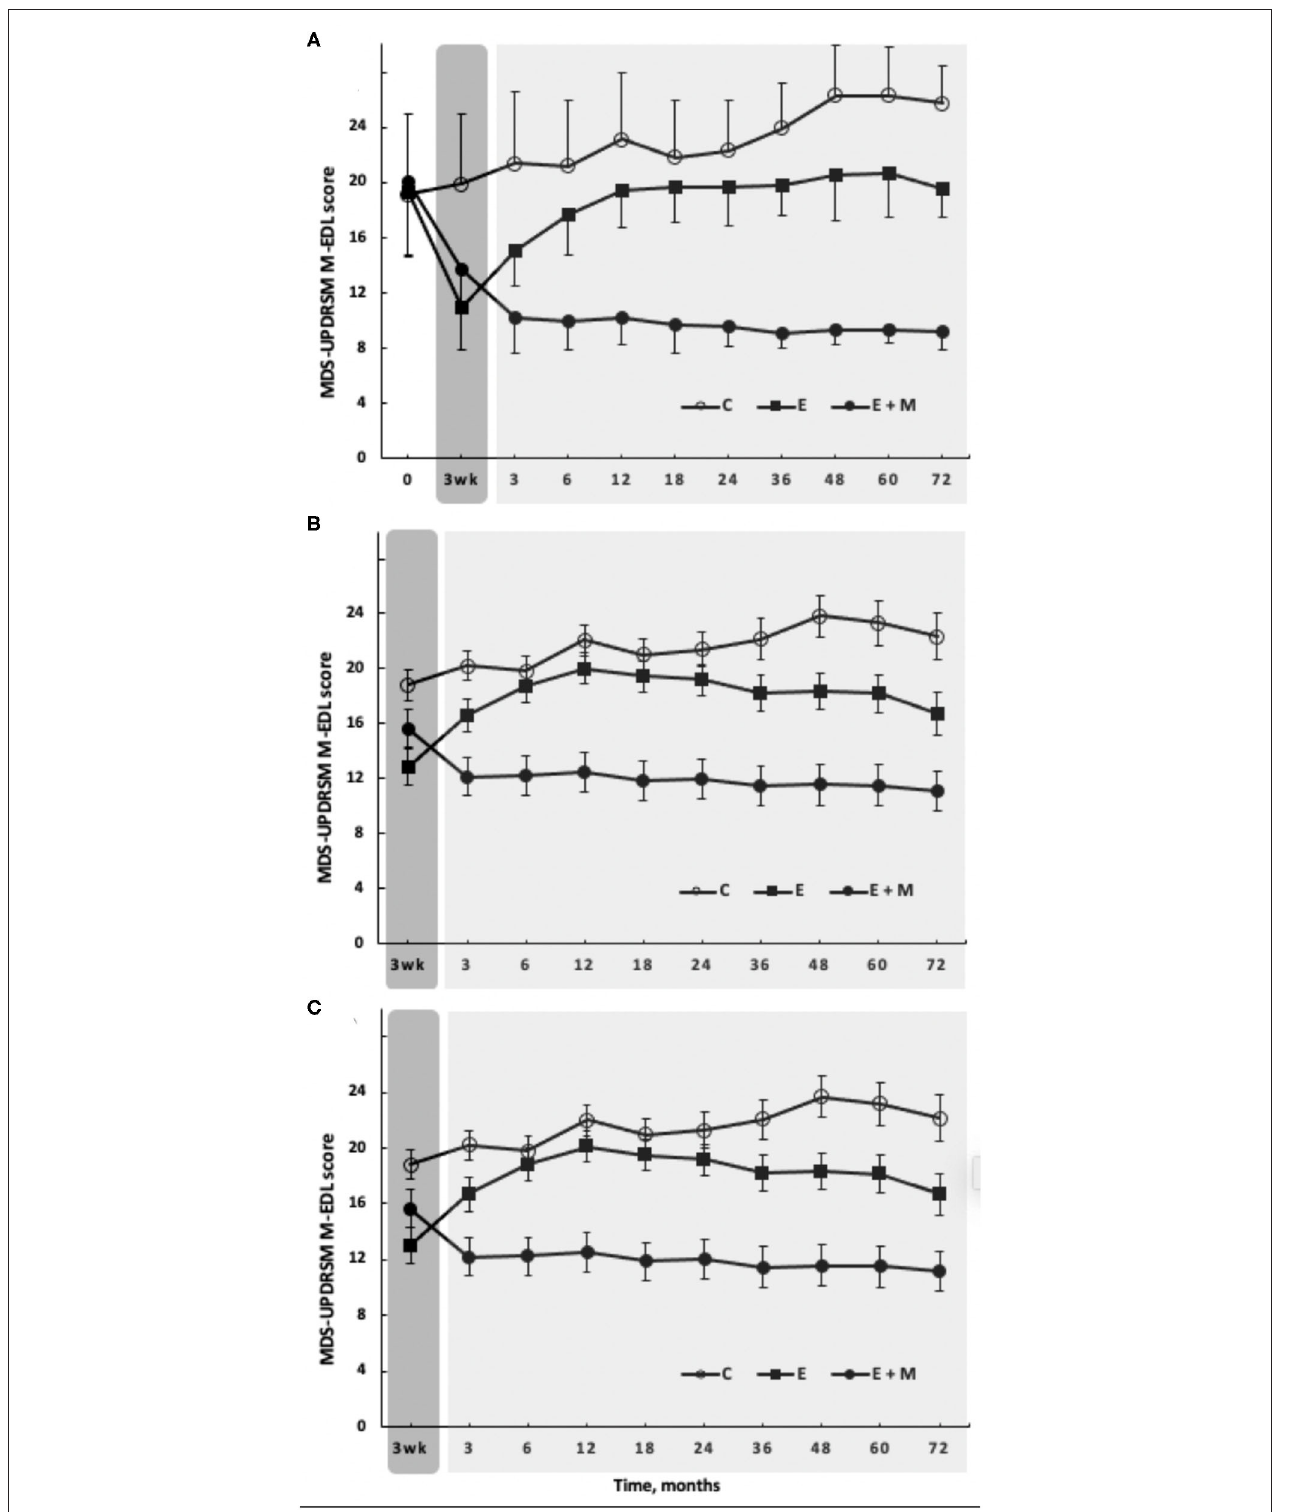
FIGURE 2 | The effects of 3-week-long, high-intensity Exergaming agility exercise program (dark gray rectangle) with (filled circles, E + M, n = 19) or without (filled squares, E, n = 22) 72-month-long Exergaming agility exercise Maintenance program, on the primary outcome, M-EDL. The Control group (C, open circles, n =